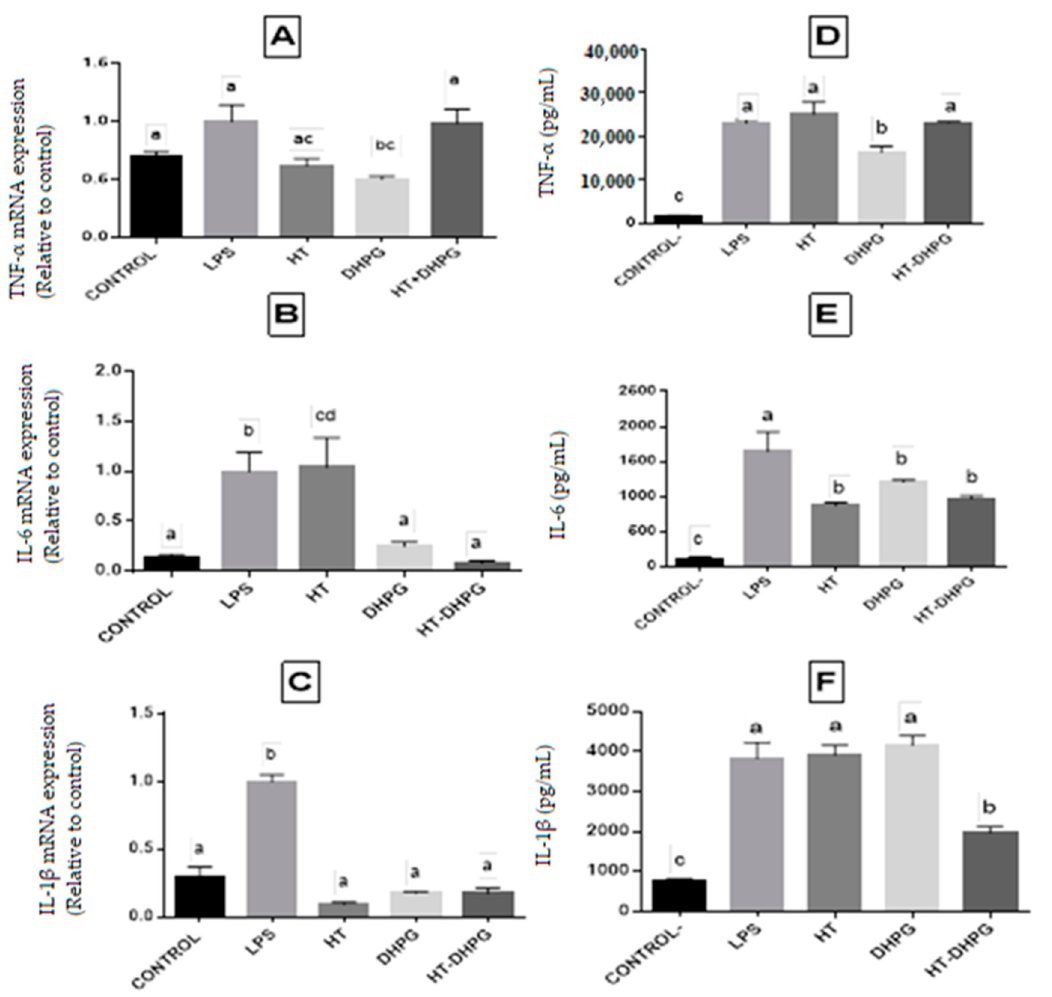
Figure 6. Human Tumor Necrosis Factor- α (TNF) ( A ), Interleukin-6 (IL-6) ( B ), Interleukin-1 β (IL-1 β ) ( C ) mRNA expression in THP-1-derived macrophages after 24 h of treatment with or without lipopolysaccharide (LPS) (100 ng/mL) and HT, DHPG and HT–DHPG. Cytokine secretion of TNF ( D ), IL-6 ( E ), and IL-1 β ( F ) production of THP-1-derived macrophages after 24 h of treatment with or without LPS (100 ng/mL) and HT, DHPG, and HT–DHPG. Values marked with different letter are significantly different ( p < 0.05).